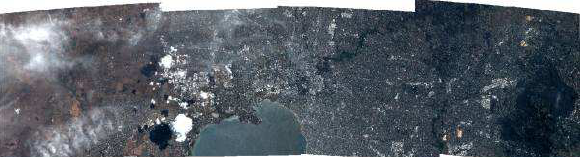
Figure 10. Pleiades-HR mosaic image of